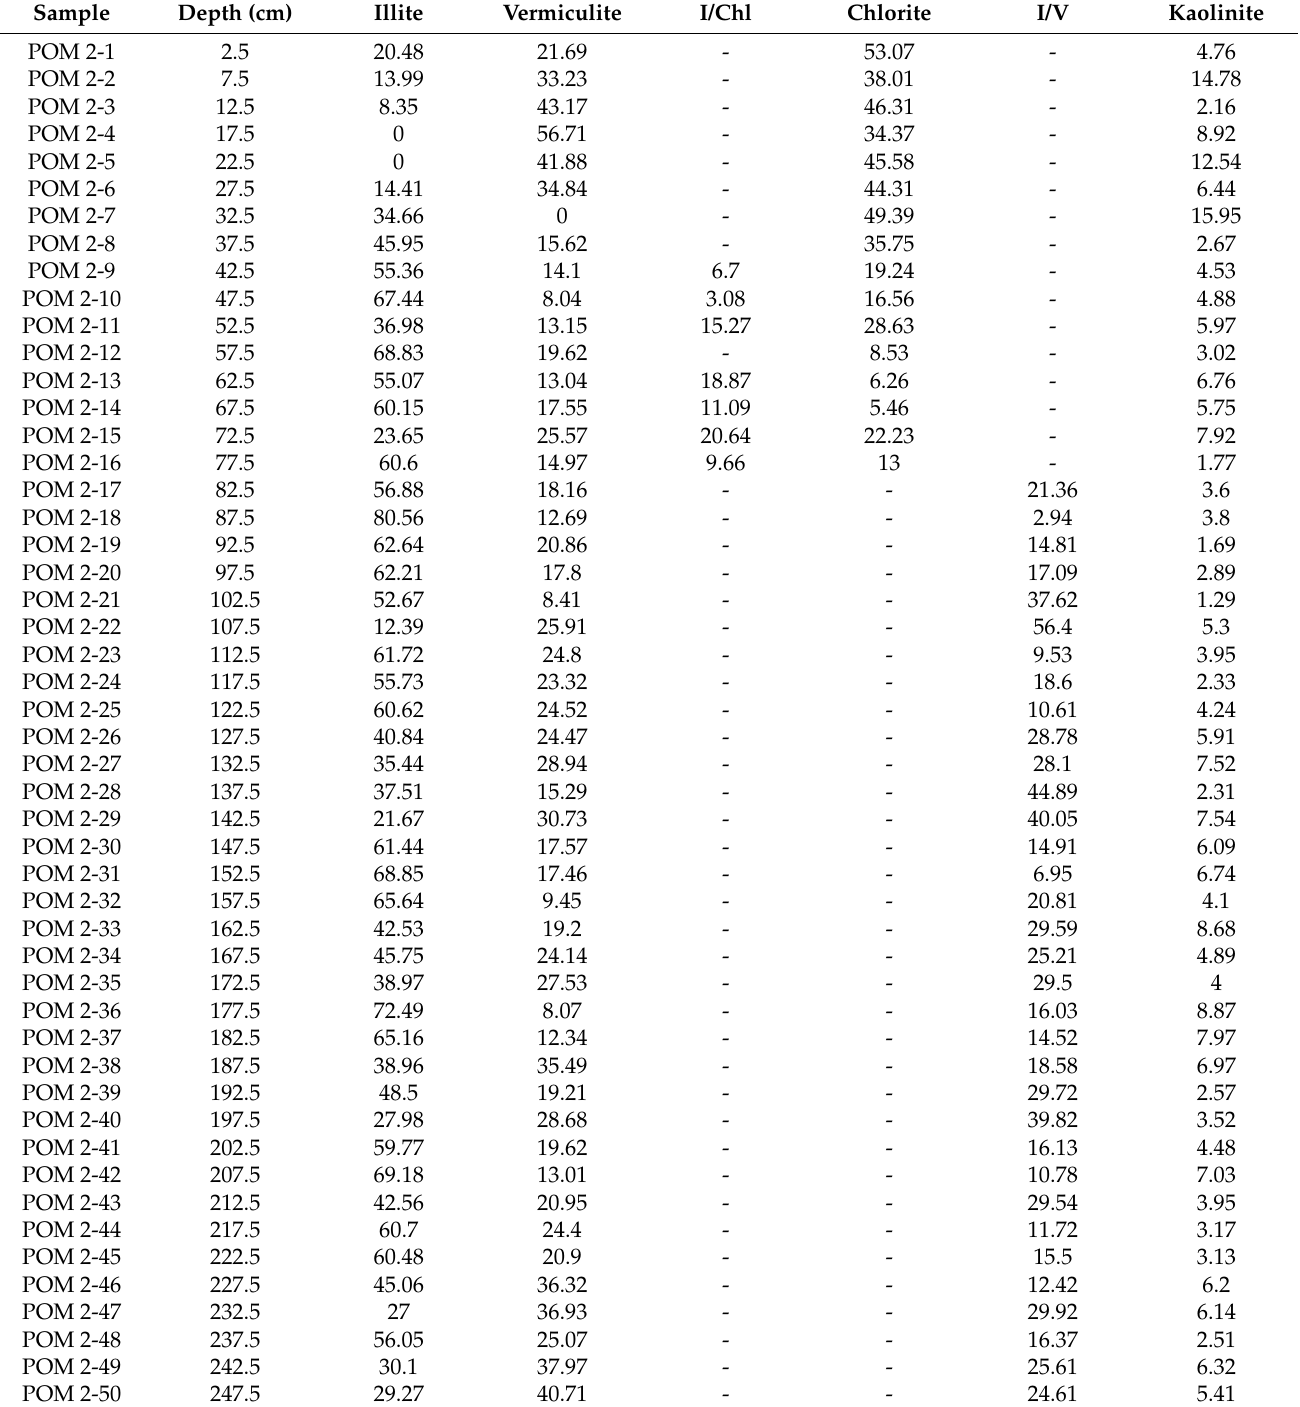
Table A1. Relative content of clay minerals of the studied profile (I/V: illite–vermiculite mixed layers; I/Chl: illite–chlorite mixed layers), values are given in